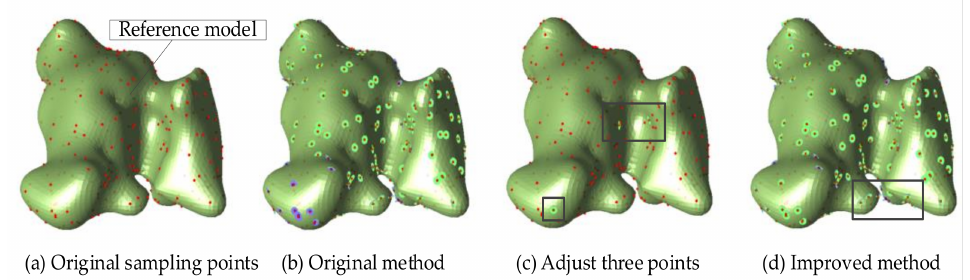
Figure 12. Normal estimation results of the fifth data set. ( a ) shows the original sampling points. ( b ) shows the normal estimation result obtained using the original method. ( c ) shows that the normal directions of the three points have been adjusted artificially. ( d ) shows the normal estimation result obtained by using the improved method, in which the black box area represents the large distortion and thin